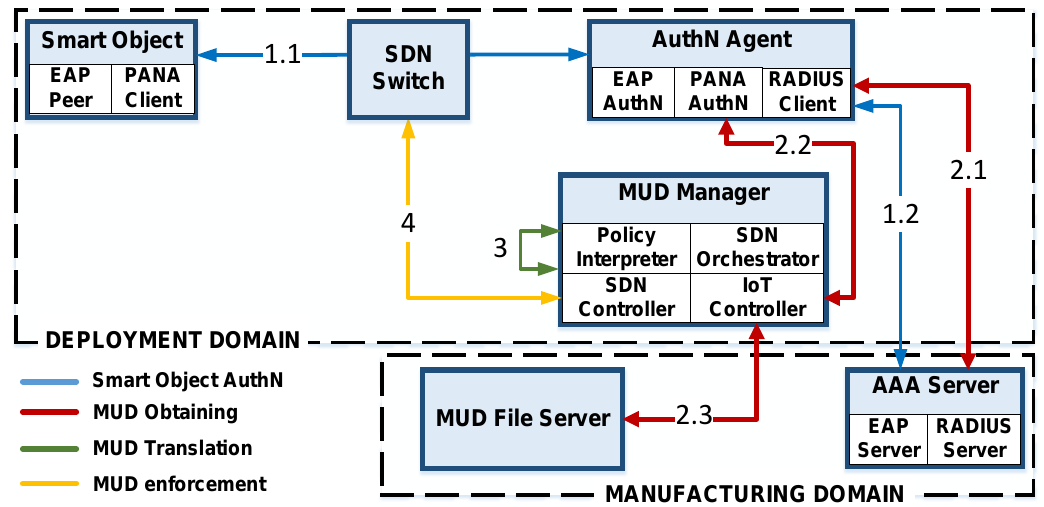
Figure 2. Architecture of the